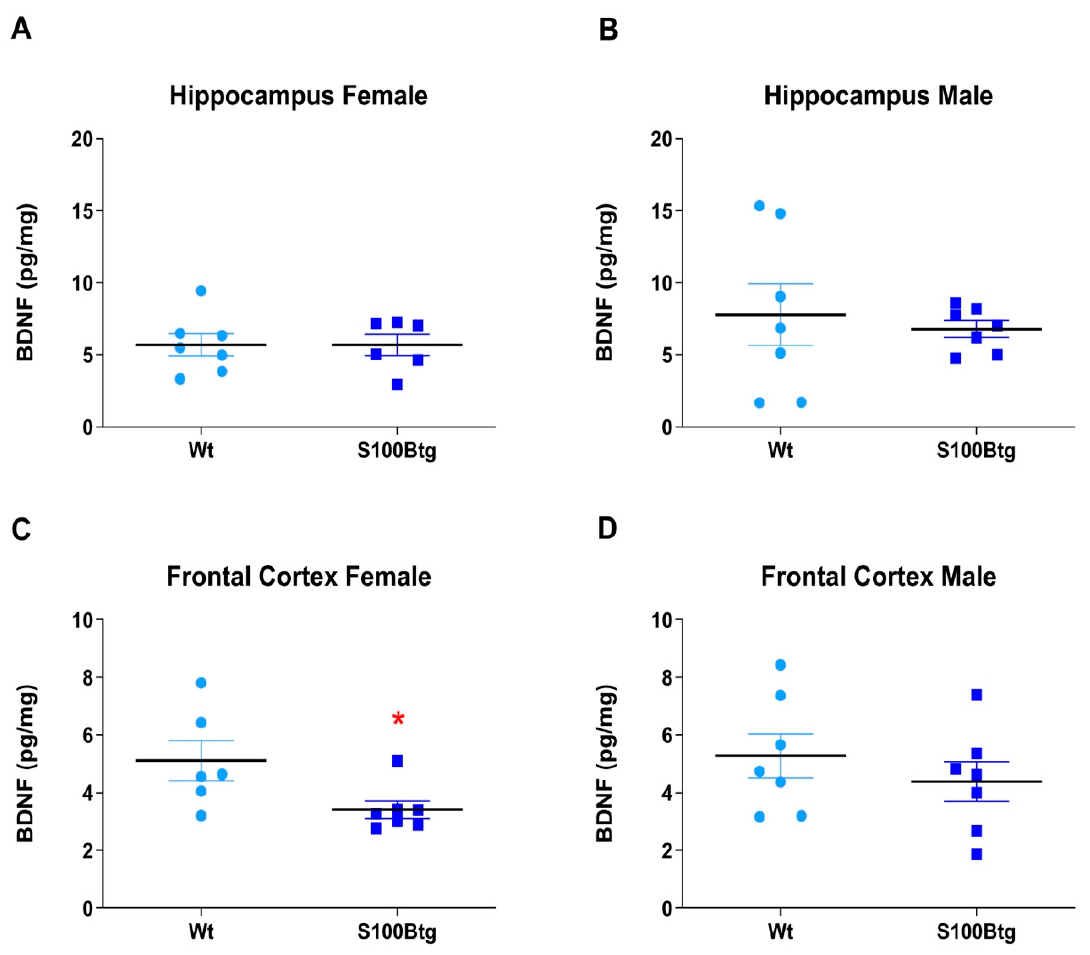
Figure 4. BDNF brain content in one-year-old S100Btg and wt mice. ( A , B ) hippocampus, and ( C , D ) frontal cortex; measurements were performed by ELISA. Data are expressed as means ± SE (7 mice/group). * Indicates a statistically significant difference (Student’s t -test, assuming p < 0.05). 2.4. Effect of Long-Term Increased S100B Levels on Hippocampal RAGE and GFAP Content GFAP and RAGE content were quantified in the hippocampus in one-year-old wt and S100Btg mice. RAGE content did not differ either in female or in male mice (Figure 5A, p = 0.944; Figure 5B, p = 0.892). The glial marker GFAP was significantly reduced in one-year-old female and male S100Btg mice (Figure 5C, p = 0.026; Figure 5D, p = 0.024).